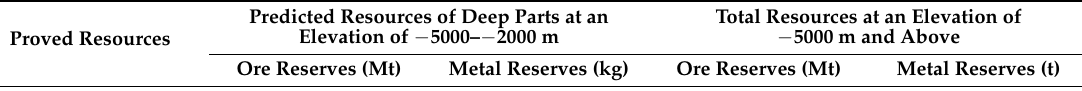
Table 8. Table 8. Predicted gold resources of major ore-controlling faults in the northwest Jiaodong